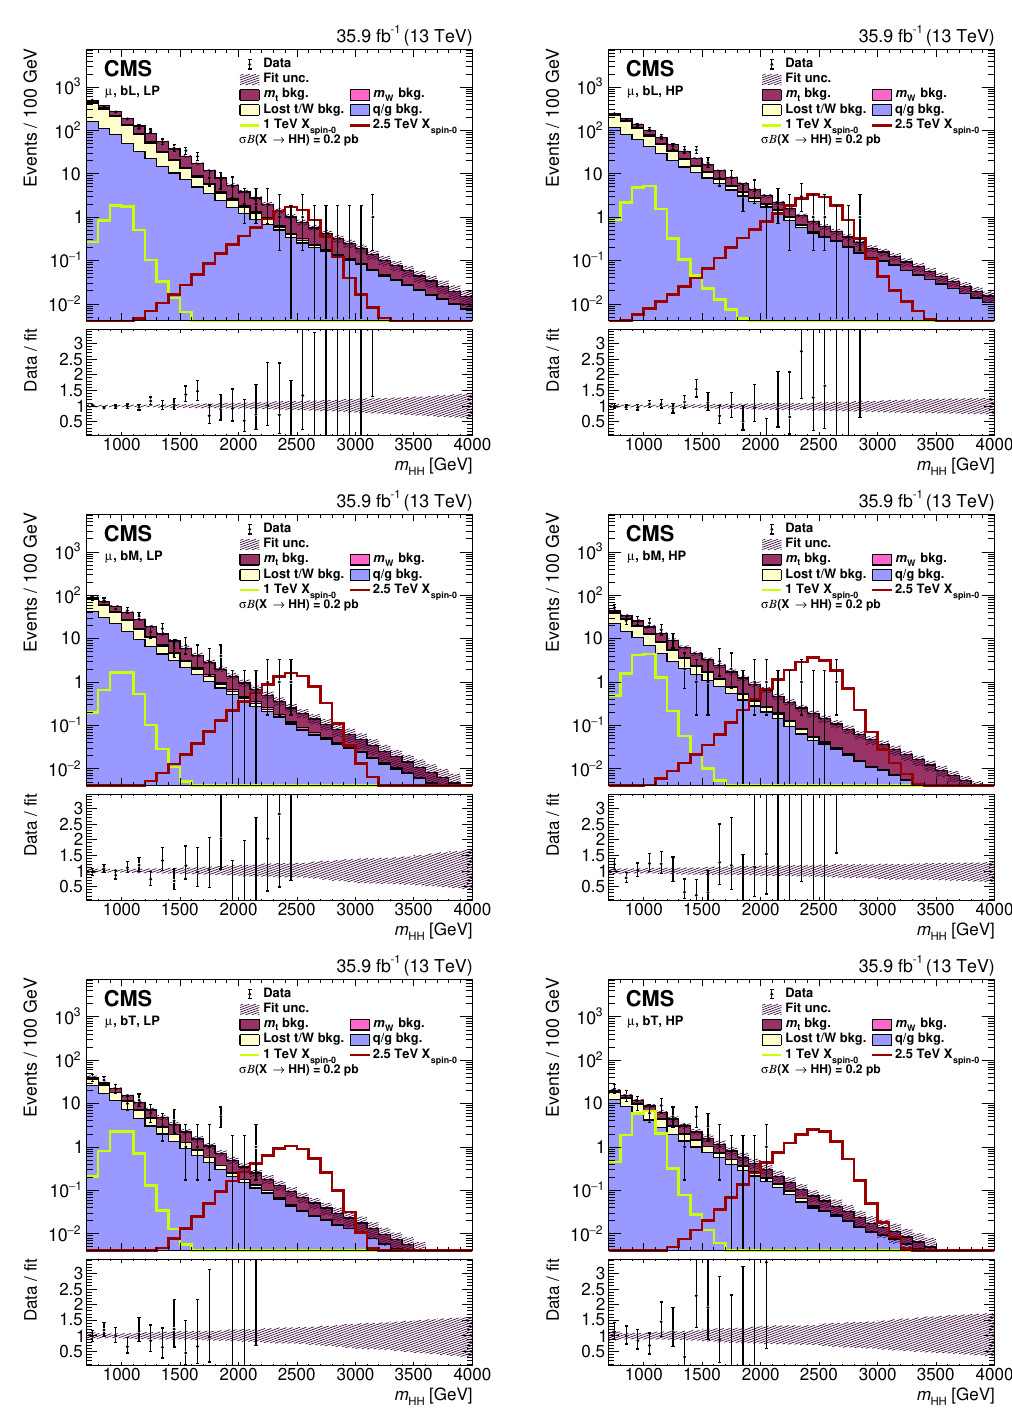
Figure 6 . The (cid:12)t result compared to data projected in m for the muon event categories. The HH (cid:12)t result is the (cid:12)lled histogram, with the di(cid:11)erent colors indicating di(cid:11)erent background categories. The background shape uncertainty is shown as the hatched band. Example spin-0 signal distribu- tions for m of 1 and 2.5 TeV are shown as solid lines, with the product of the cross section and X branching fraction to two Higgs bosons set to 0.2 pb. The lower panels show the ratio of the data to the (cid:12)t result.